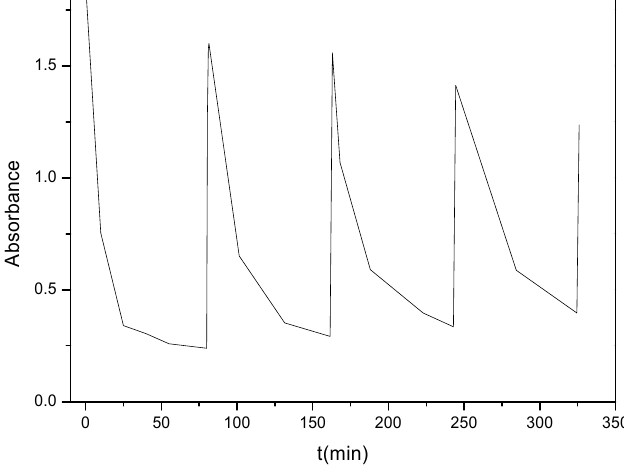
Figure 3. Efficiency of consecutive photodimerisation and photocleavage reactions from absorbance at 319 nm of a photoreactive polyurethane. Reprinted with permission from [110] (©2016, Elsevier).